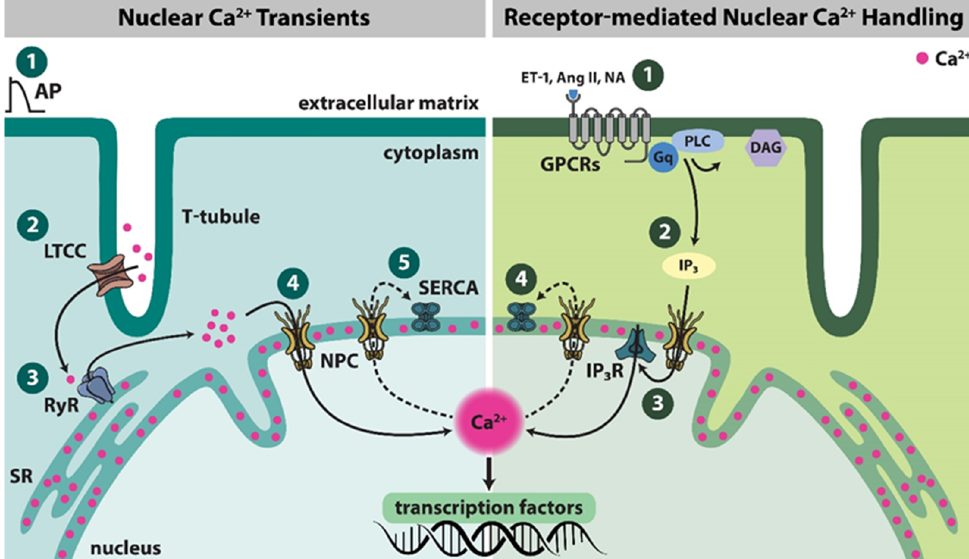
Figure 1. Nuclear Ca 2+ handling in cardiomyocytes. ( Left ) Cardiac action potential (AP) causes myocyte membrane depolarization (1) and creates an inward Ca 2+ current through opening of L-type Ca 2+ channels (LTCC) located at the plasma membrane, including T-tubules (2). Increased local Ca 2+ concentration ([Ca 2+ ]) triggers the release of Ca 2+ stored in the sarcoplasmic reticulum (SR) via ryanodine receptors (RyR) (3). Nuclear pore complexes (NPC) facilitate passive diffusion of free cytoplasmic Ca 2+ into the nucleus (4), where the transient rise in [Ca 2+ ] nuc can mediate transcriptional e ff ects. For [Ca 2+ ] nuc to decline, Ca 2+ has to di ff use back out of the nucleus through NPCs to be taken up into the nuclear envelope by SR Ca 2+ ATPase (SERCA) expressed on the outer nuclear membrane (5). ( Right ) G-protein coupled receptors (GPCRs) are stimulated by endothelin-1 (ET-1), angiotensin II (Ang II) or noradrenaline (NA) and activate phospholipase C (PLC) (1), which synthesizes diacylglycerol (DAG) and inositol-1,4,5-triphospate (IP 3 ) (2). IP 3 then passively di ff uses through NPCs to initiate Ca 2+ release from the nuclear envelope via IP 3 receptors (IP 3 R) and thus elicits a nuclear Ca 2+ release (3). Increased [Ca 2+ ] nuc can again exert e ff ects on transcription factors before di ff using back out of the nucleoplasm via NPCs and being taken up by SERCA expressed on the outer nuclear membrane (4).